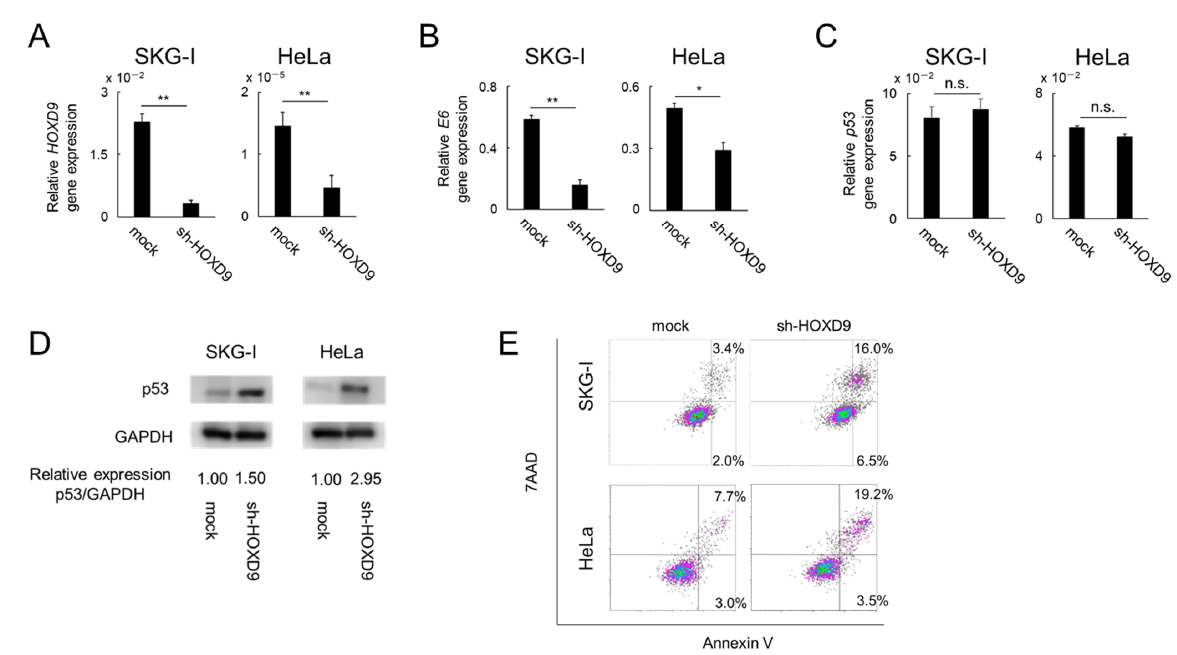
Figure 2. Knockdown of HOXD9 gene induces apoptosis through low E6 expression and suppression of p53 degradation. SKG-I and HeLa cells were transfected with shRNA-HOXD9 (sh-HOXD9) or shRNA-empty vector (mock). ( A – C ) Total RNA was extracted and HOXD9 ( A ), E6 ( B ), and TP53 ( C ) mRNA was evaluated by real-time RT-PCR at 48 h post-transfection. (means ± SD; n = 3) ( D ) Extracted proteins were separated by SDS-PAGE and transferred to PVDF membranes. The blotted proteins were probed with anti-GAPDH and anti-p53 antibodies. ( E ) Apoptotic monitoring was performed by staining with FITC-conjugated annexin V and 7-AAD. The percentages of annexin V+/7-AAD- cells (representing cells in the early stage of apoptosis) and annexin V+/7-AAD+ cells (representing cells in the late stage of apoptosis) were determined by flow cytometry. * p < 0.05, ** p < 0.01. n.s.: not